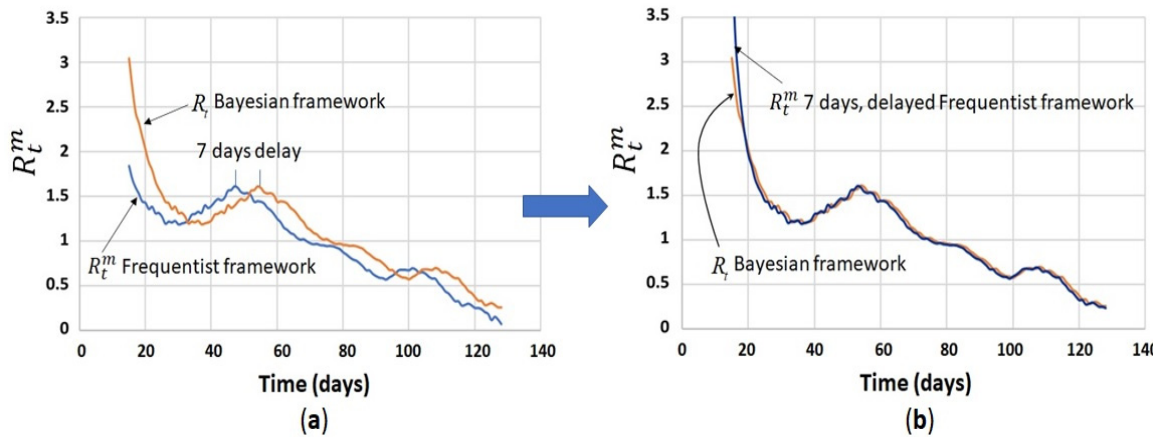
Figure 12. Instantaneous reproduction number calculated through Bayesian and Frequentist frame- work without serial interval uncertainty: ( a ) Superposition curves of both methods; and ( b ) Superposition curves delaying the Frequentist method curve by 7 days.